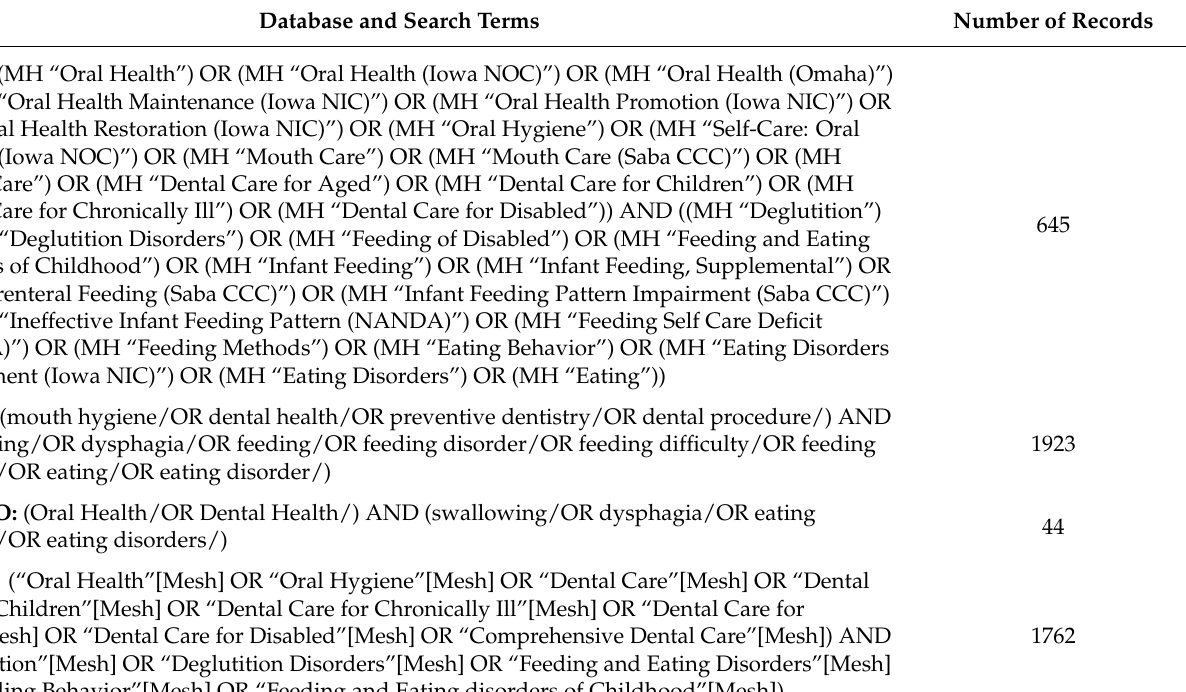
Table 1. Search strategies for each literature